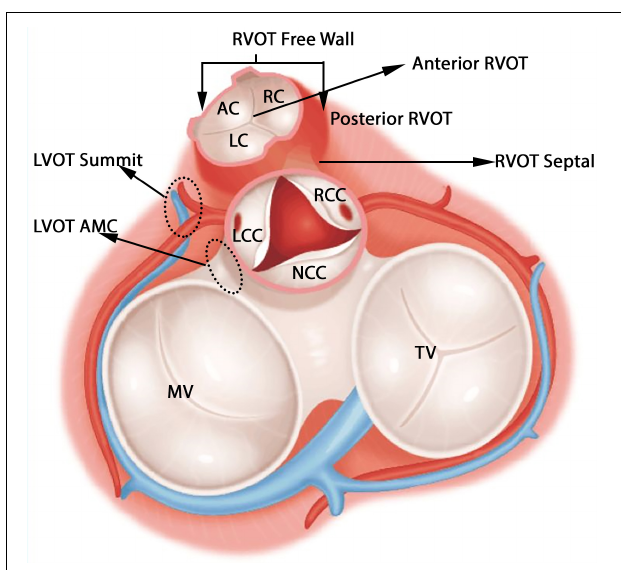
FIGURE 2 | Anatomic structure of LVOT and RVOT. LVOT includes left coronary cusp (LCC), right coronary cusp (RCC), non-coronary cusp (NCC), aortomitral continuity (AMC), and LVOT summit. RVOT includes anterior cusp (AC), left cusp (LC), right cusp (RC), RVOT freewall, and RVOT